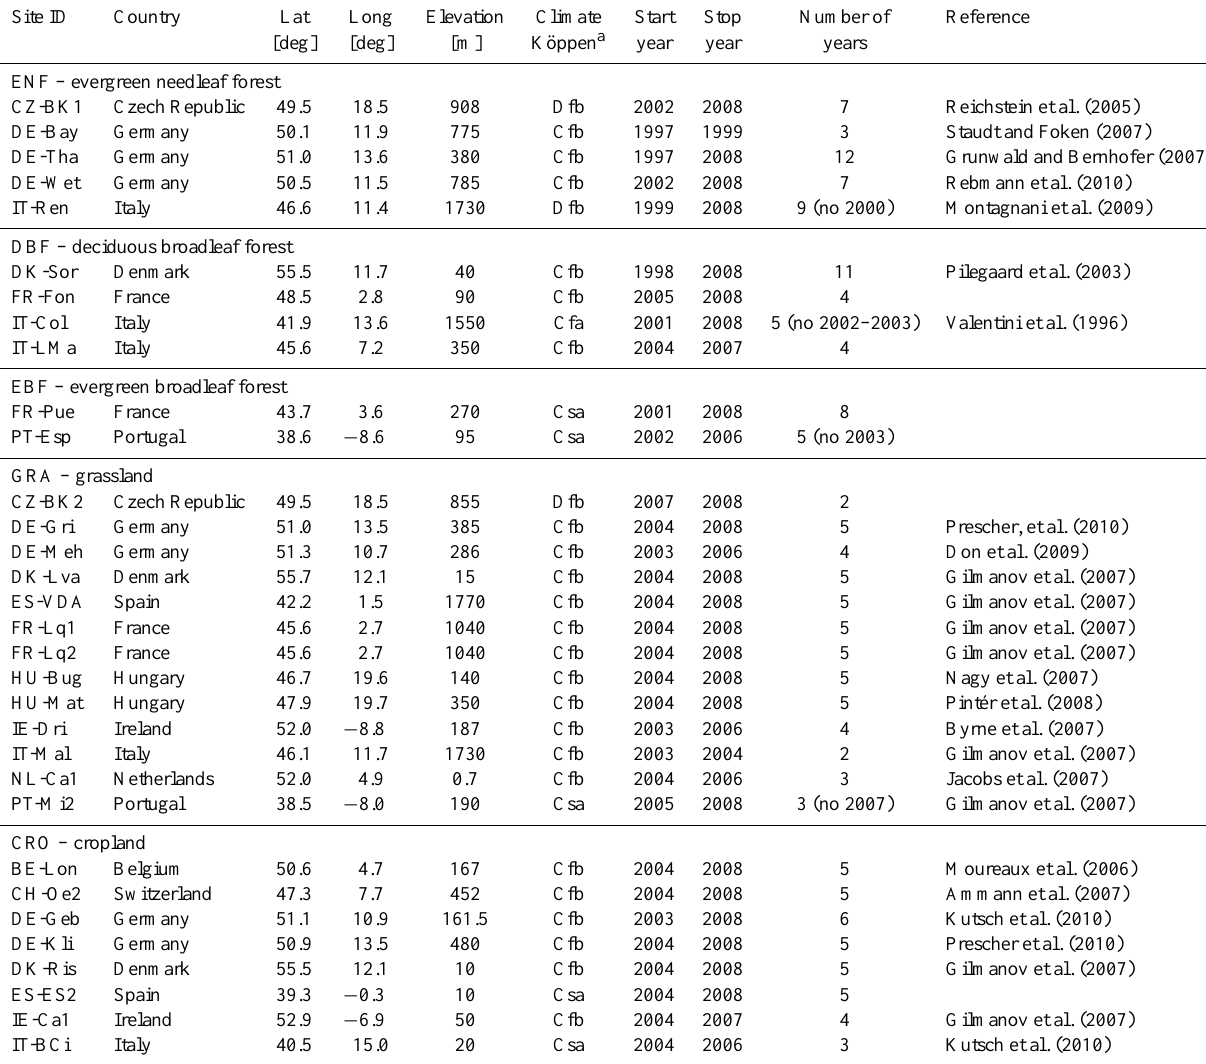
Table 1. List of sites and years used for the models evaluation and characteristics. Site